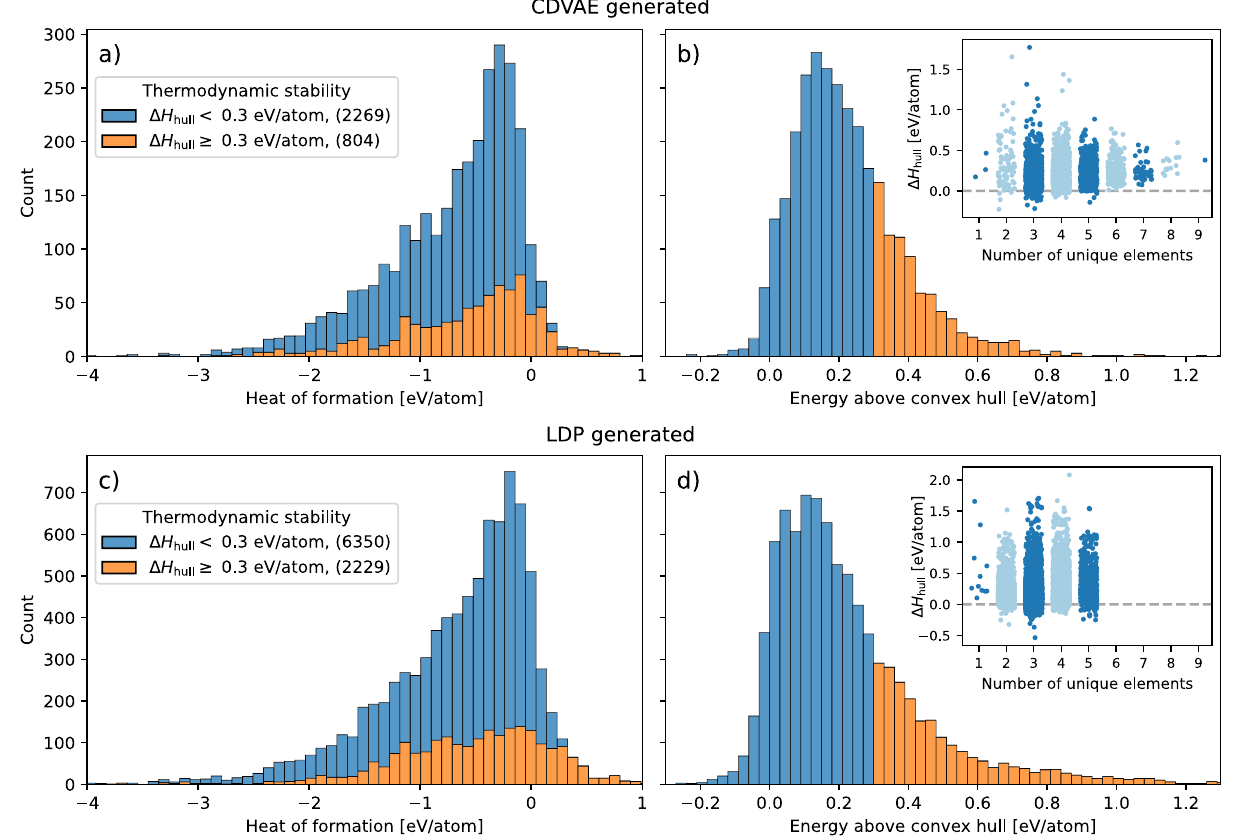
Fig. 3 Histogram of the heat of formation and energy above convex hull for the DFT-relaxed structures resulting from the CDVAE and LDP methods. a , b CDVAE generated structures ( c , d ) LDP generated structures. The inset shows the energy above convex hull with respect to the number of unique elements in the